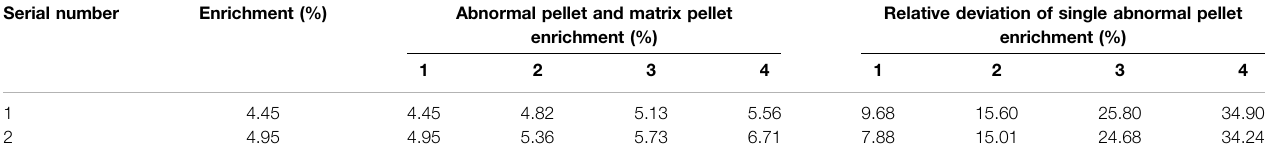
TABLE 2 | 4.45% Enrichment standard rod information.